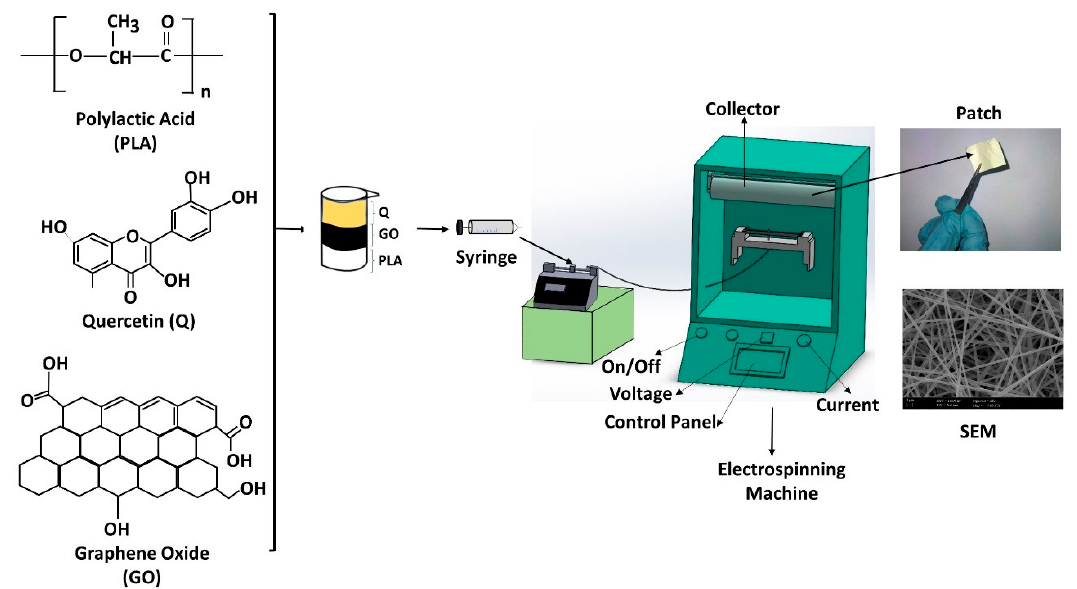
Figure 1. Schematic illustration of the idea, fabrication, and methods.